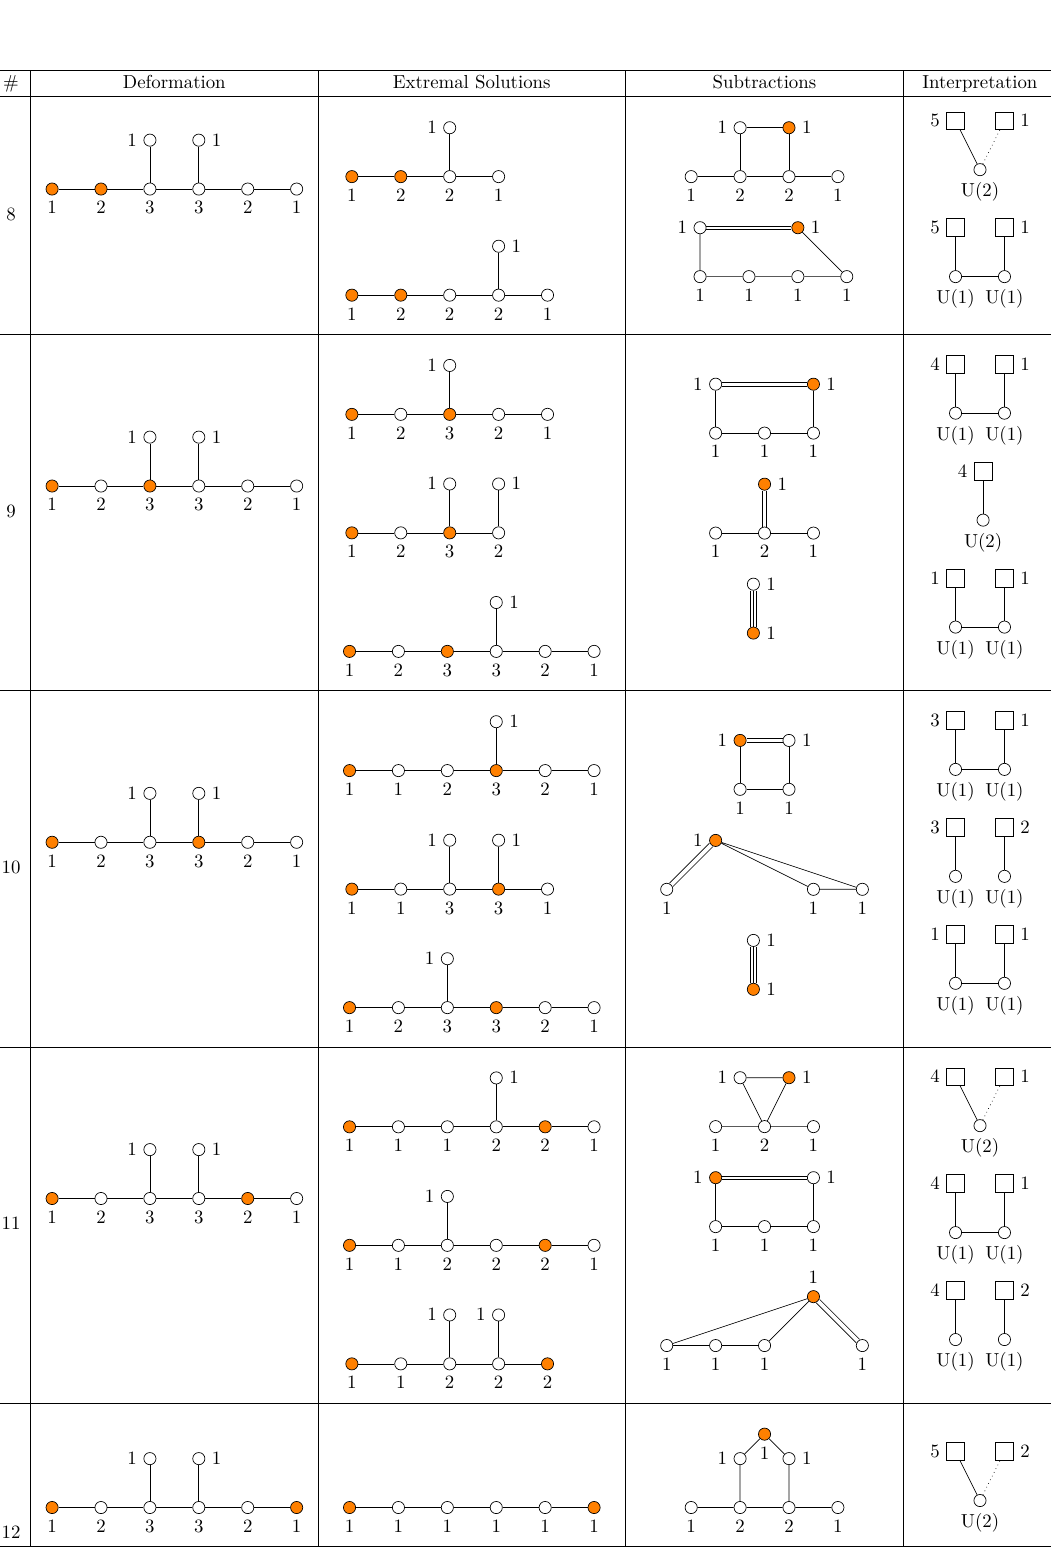
Table 4 . Analysis for SU(3) with 7 flavors